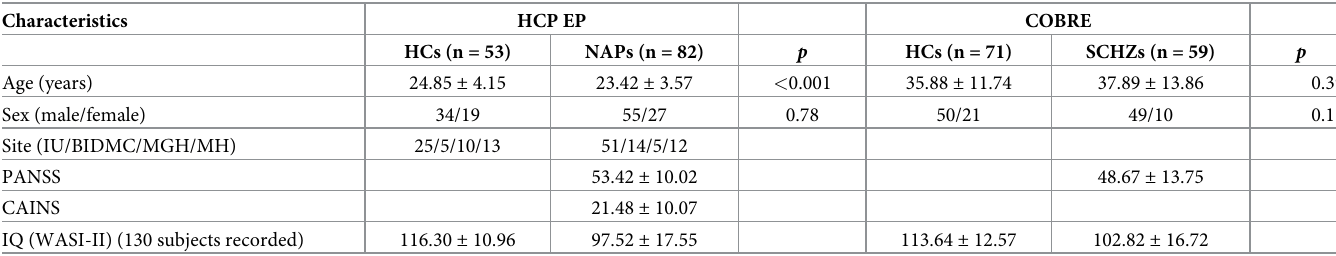
Table 7. Demographic characteristics of participant